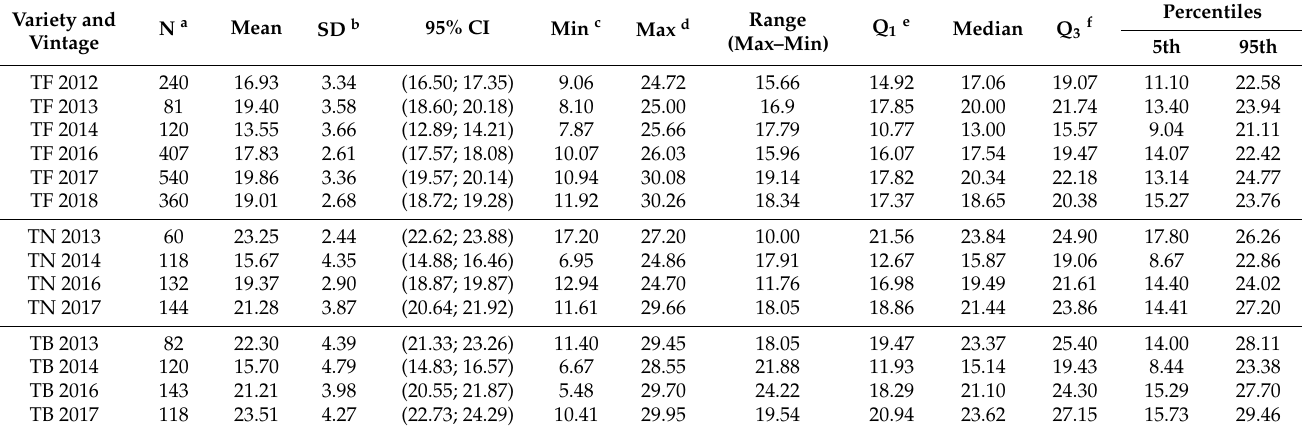
Table 3. Summary of the descriptive statistics for the reference measurements of sugar contents by variety and vintage. Variety and